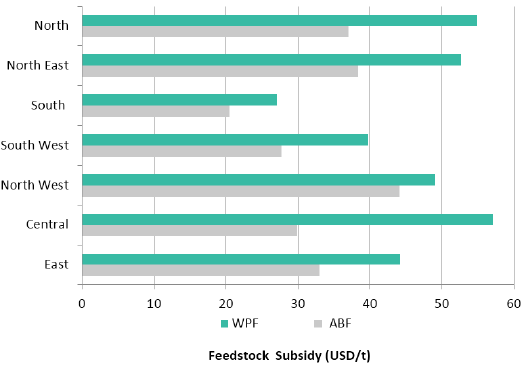
Figure 13. Required feedstock subsides for each region.